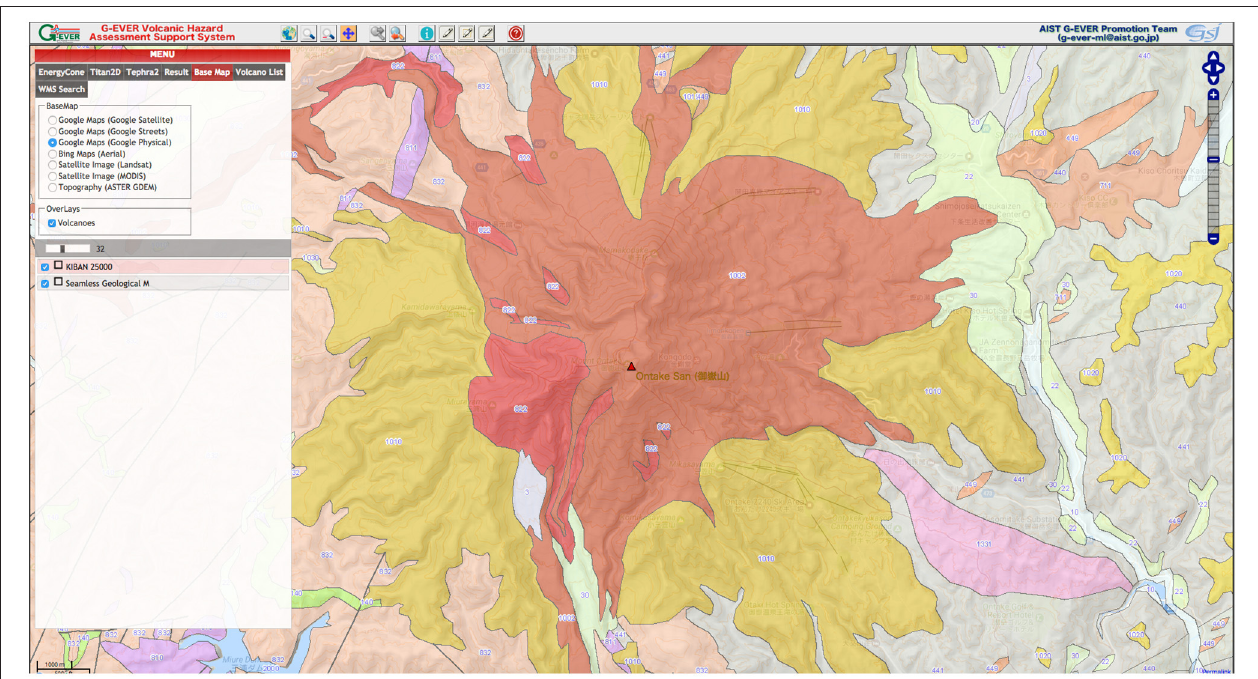
FIGURE 3 | Available base maps on the VHASS system. The 1:200,000 seamless geological map of Japan and the 1:25,000 topographic map of Japan are overlain on the Google maps (physical) covering Japan.